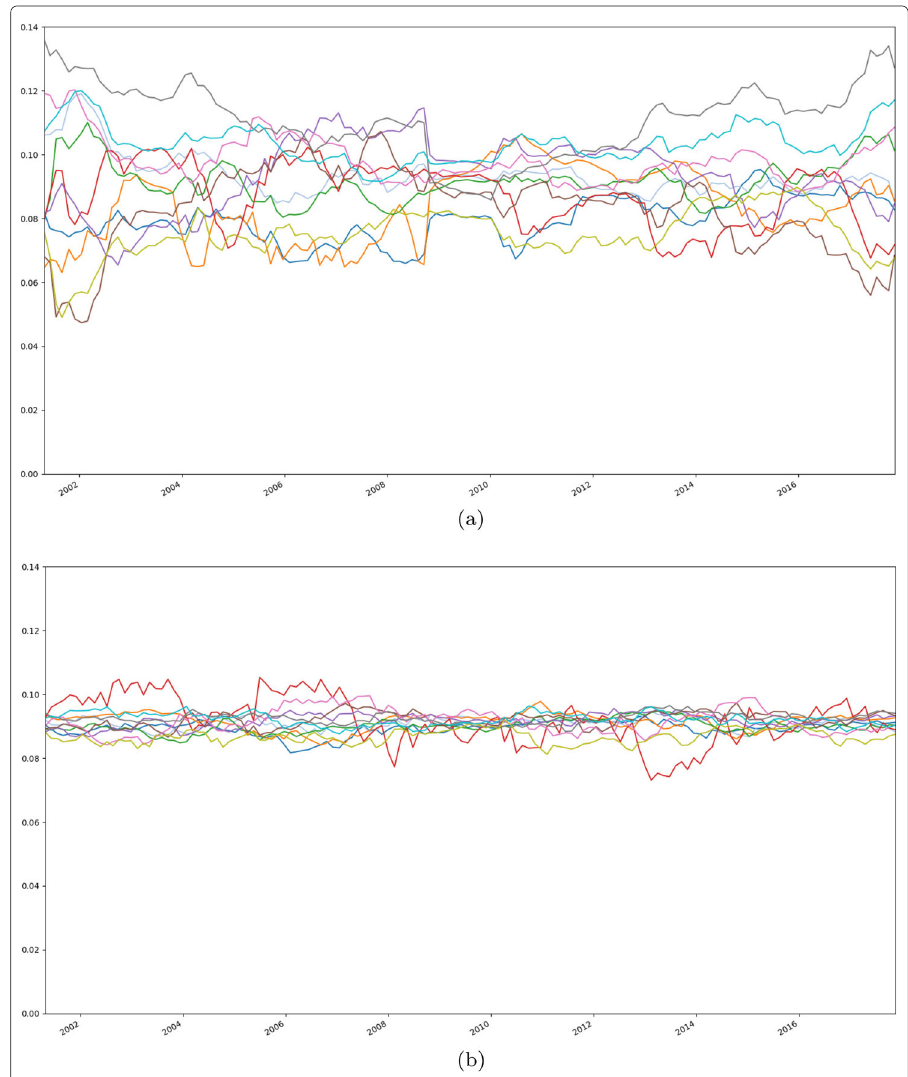
Fig. 7 Mean degree centrality for each sector over time. It is noticeable that in the partial correlation networks the difference in centrality is much smaller for each sector than in the correlation networks. We can see the macroeconomic trends in the correlation networks with the centralities jumping together during the crash. The colour legend can be found in Fig. 8. a Correlation b Partial